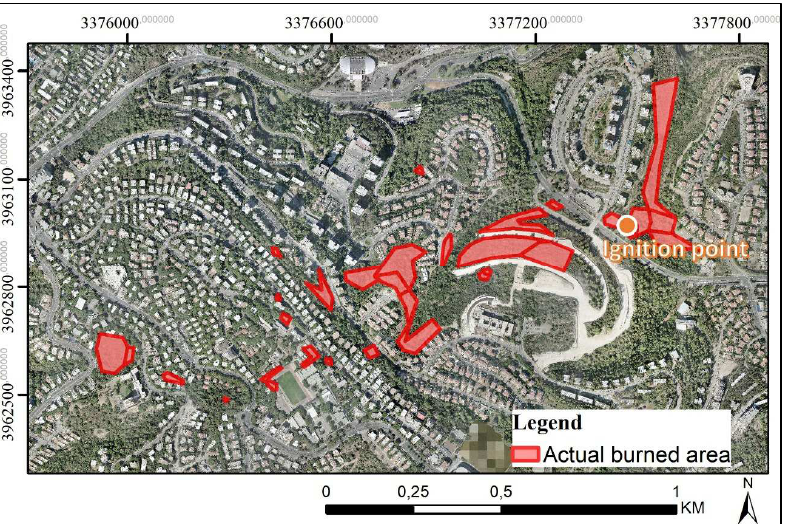
Figure 1. Map of the actual burned area at the first hour of the wildfire event in Haifa on 24 Novem- ber 2016 [48].